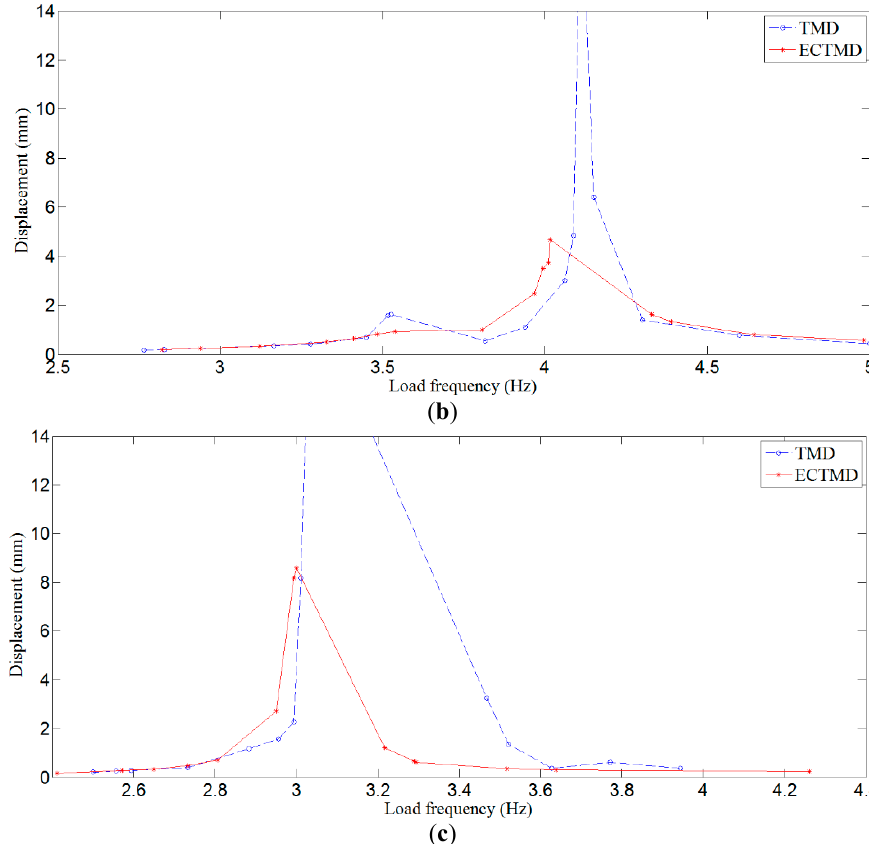
Figure 7. Frequency responses of the cantilever beam in different detuned situations. ( a ) Detuned ratio 0%; ( b ) Detuned ratio 14.7%; ( c ) Detuned ratio − 13.3%.